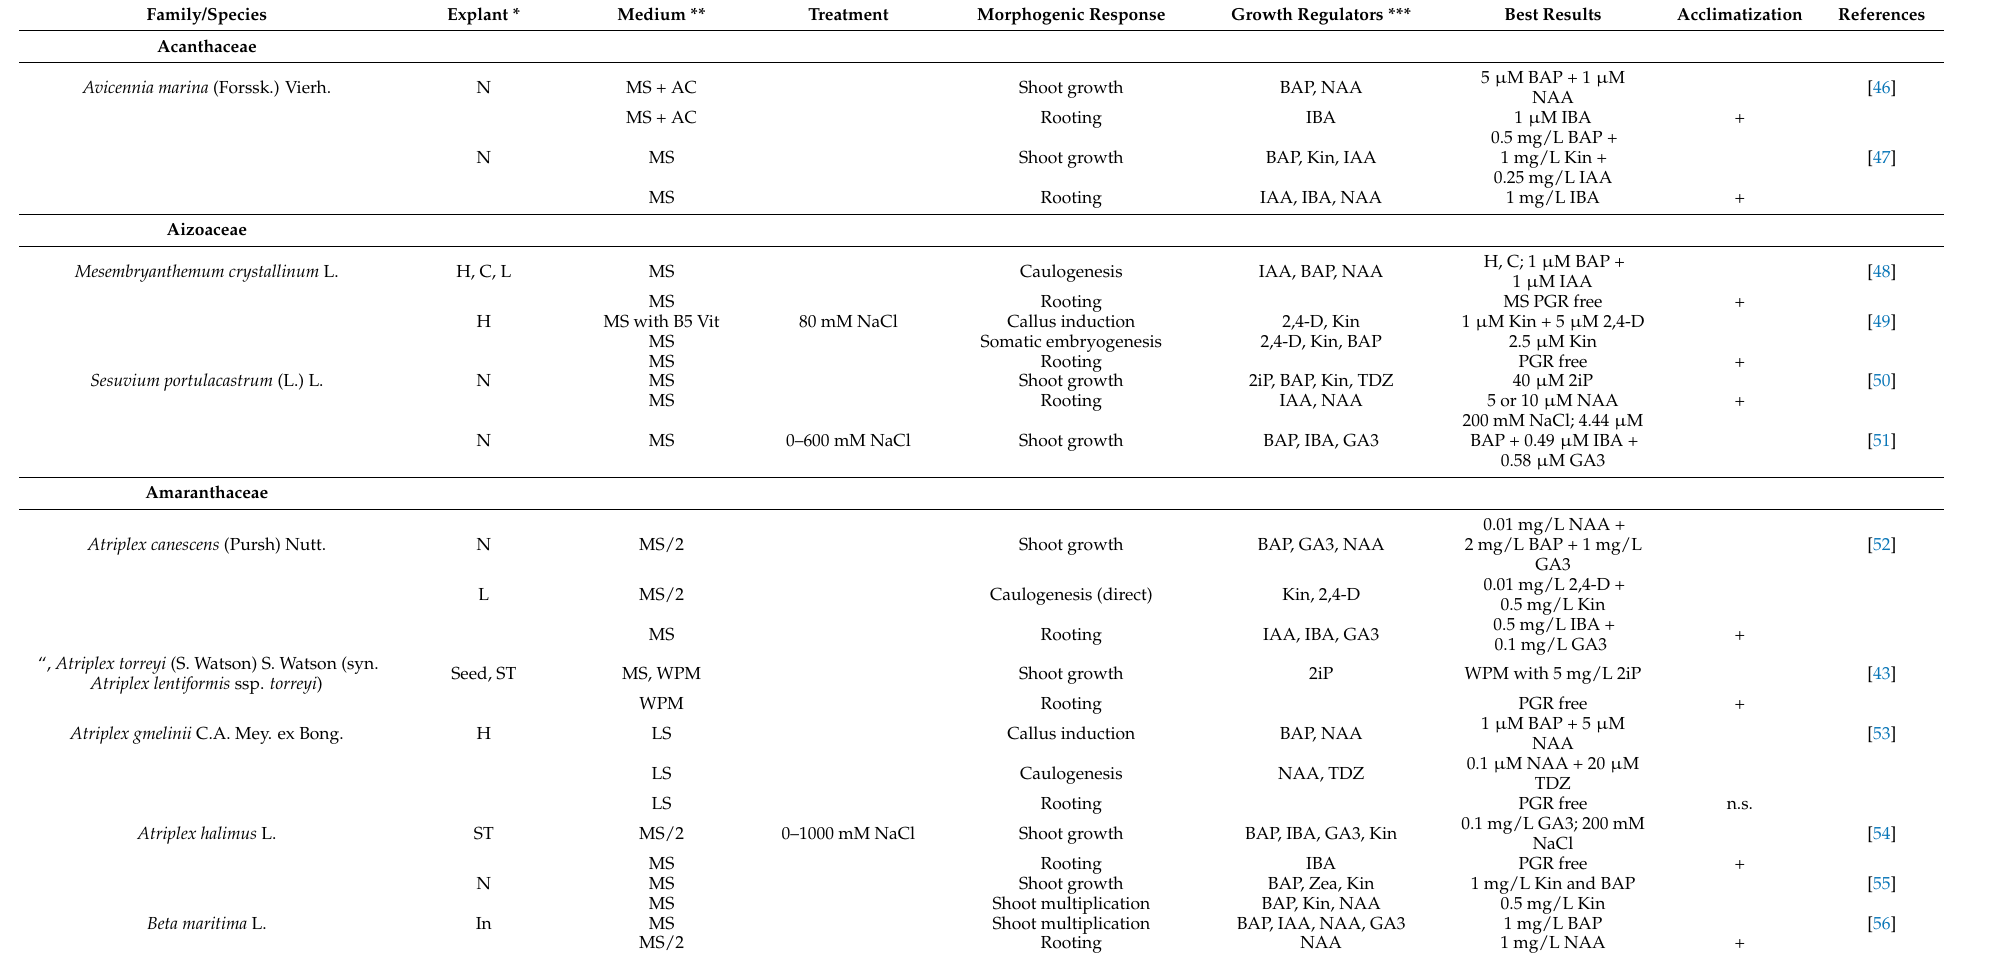
Table 1. Direct and indirect micropropagation experiments derived from buds, adventitious shoots, or somatic embryos reported in halophyte